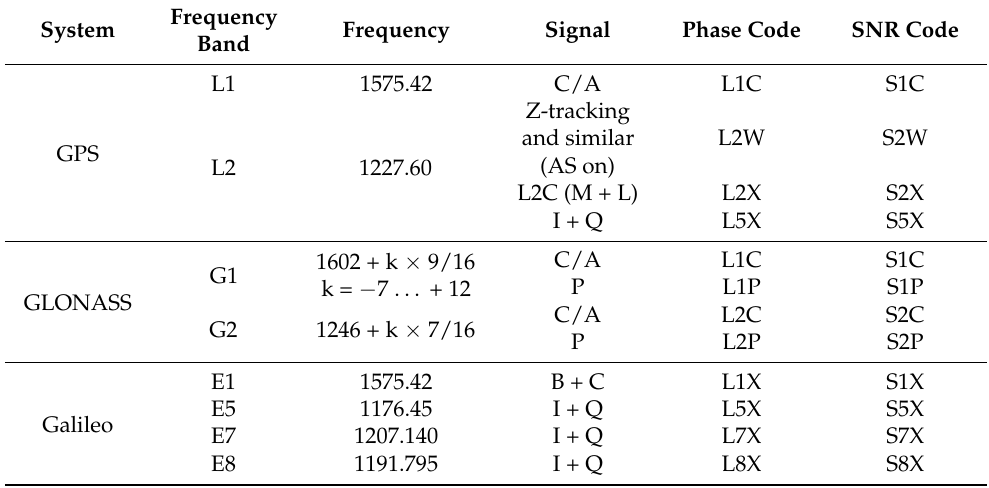
Table 1. System, frequency band, frequency, phase code, and SNR code of each signal for HKQT [27].